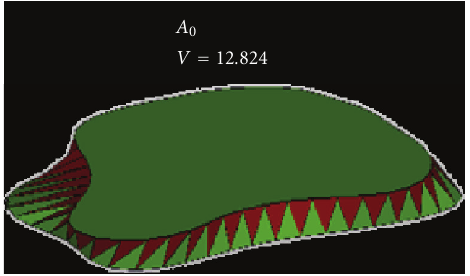
Figure 9: Two parallel contours and 50 points on each one.